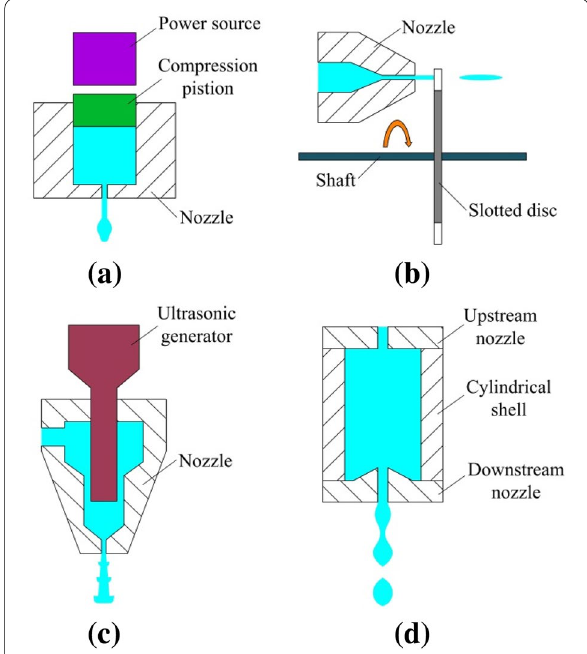
Figure 1 Types of pulsed